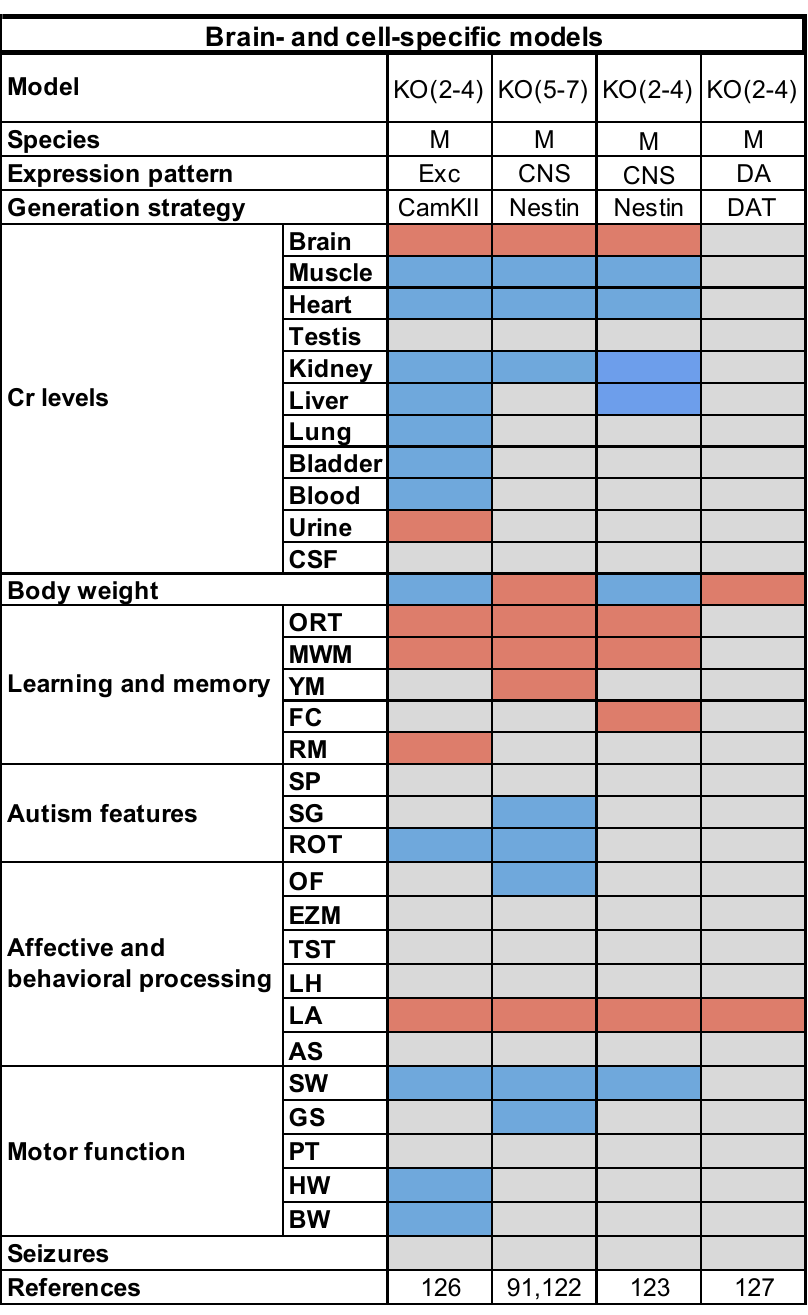
Figure 2. Heatmap representation of the cluster of conditional models for CTD carrying different deletions of SLC6A8 gene restricted to specific brain districts. Species (M: mouse), expression pattern of mutated allele (Exc: excitatory neurons; CNS: postmitotic neurons, glial cells and BBB endothelial cells of central nervous system; DA: dopaminergic neurons) and model generation strategy (the promoter driving Cre-recombinase expression) were also cited. The phenotypic traits for each model are indicated (ORT: object-recognition task; MWM: Morris water maze; YM: Y maze; FC: fear conditioning; RM: radial maze; SP: social preference; SG: self-grooming; ROT: rotarod; OF: open field; EZM: elevated zero maze; TST: tail suspension test; LH: learned helplessness; LA: locomotor activity; AS: acoustic startle; SW: swimming behavior; GS: grip strength; PT: pole test; HW: hang wiring; BW: beam walk). Red squares mean significantly higher or lower performance with respect to WT animals. Blue squares refer to phenotypes with no differences between genotypes. Grey squares are for not investigated tasks.